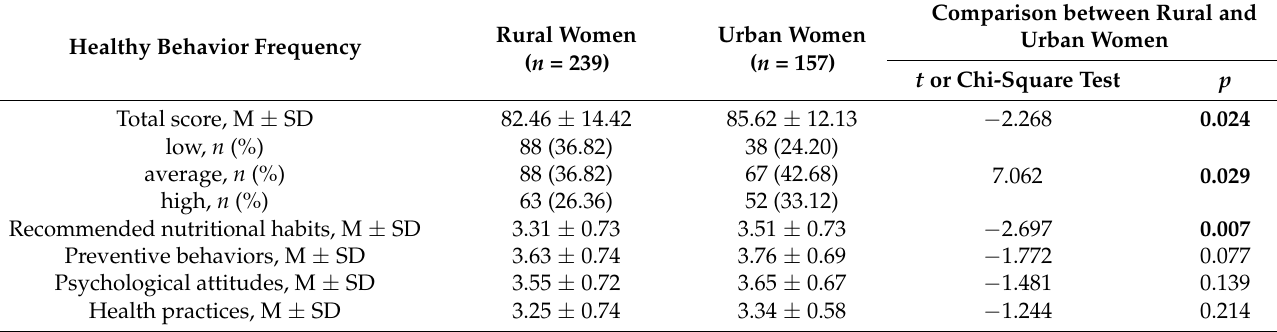
Table 4. Healthy behavior frequency in study